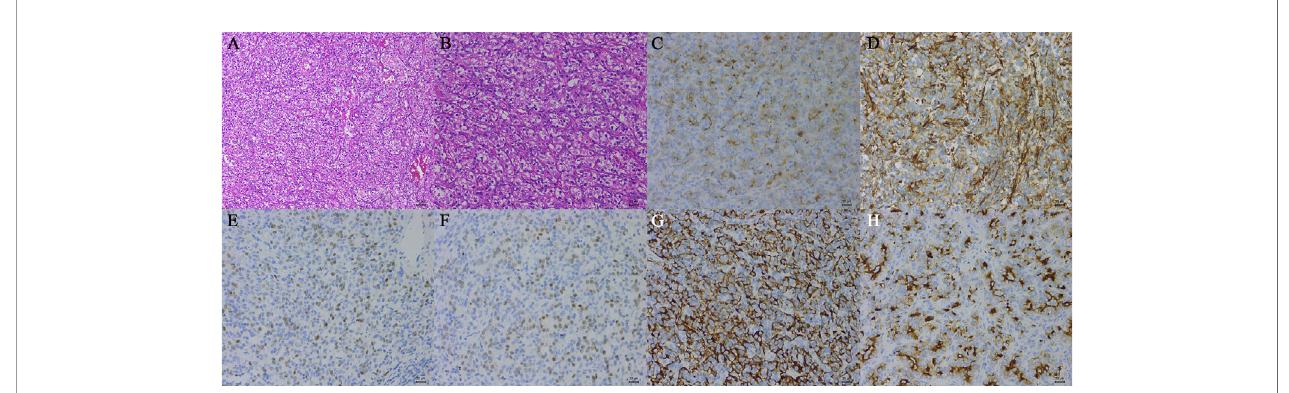
FIGURE 2 | Histopathological examination of tissue samples (hematoxylin-eosin, original magni fi cation, A: ×100, B: ×200). The tumor cells were positive for CD10 (C) , vimentin (D) , PAX-2 (E) , PAX-8 (F) , CK-Pan (G) , and the RCC marker (H) (immunohistochemistry, original magni fi cation,